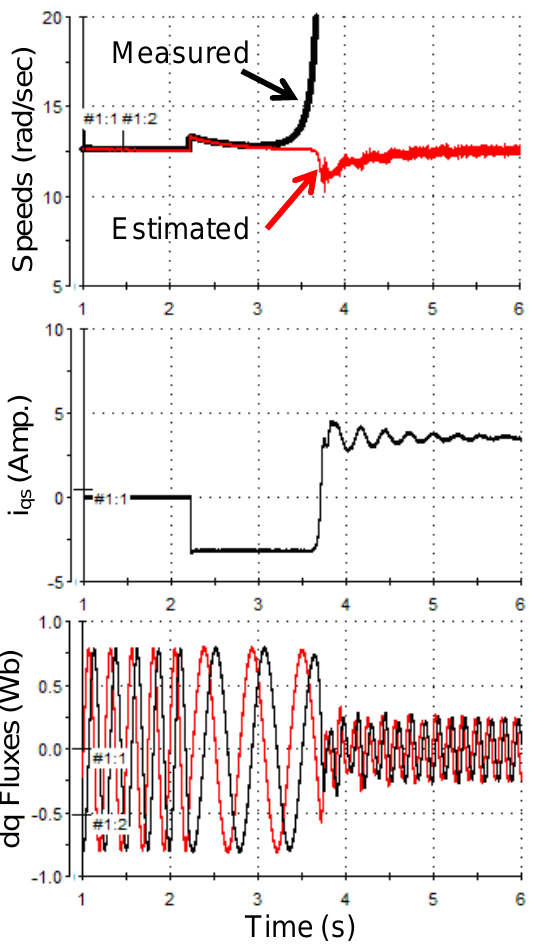
Figure 12. Practical tests at a speed reference of 0.08 p.u (12.56 rad/s) with rated T L change of − 7 N.m at t = 2 s. Unstable AFO ( K 1 = K 2 = 0).